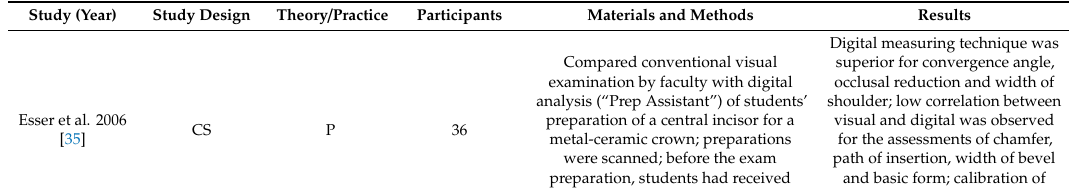
Table 2. Digital surface mapping ( n =